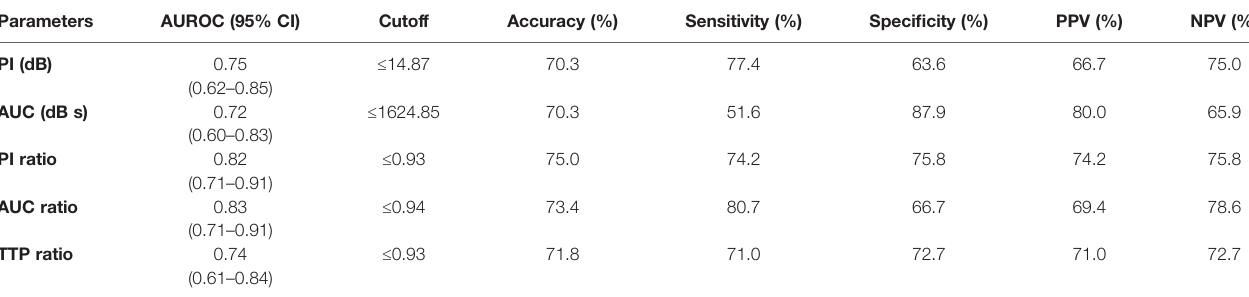
TABLE 4 | Diagnostic performance of CEUS quanti fi cation parameters in distinguishing PTL from NHT in patients with Hashimoto ’ s thyroiditis background. Parameters